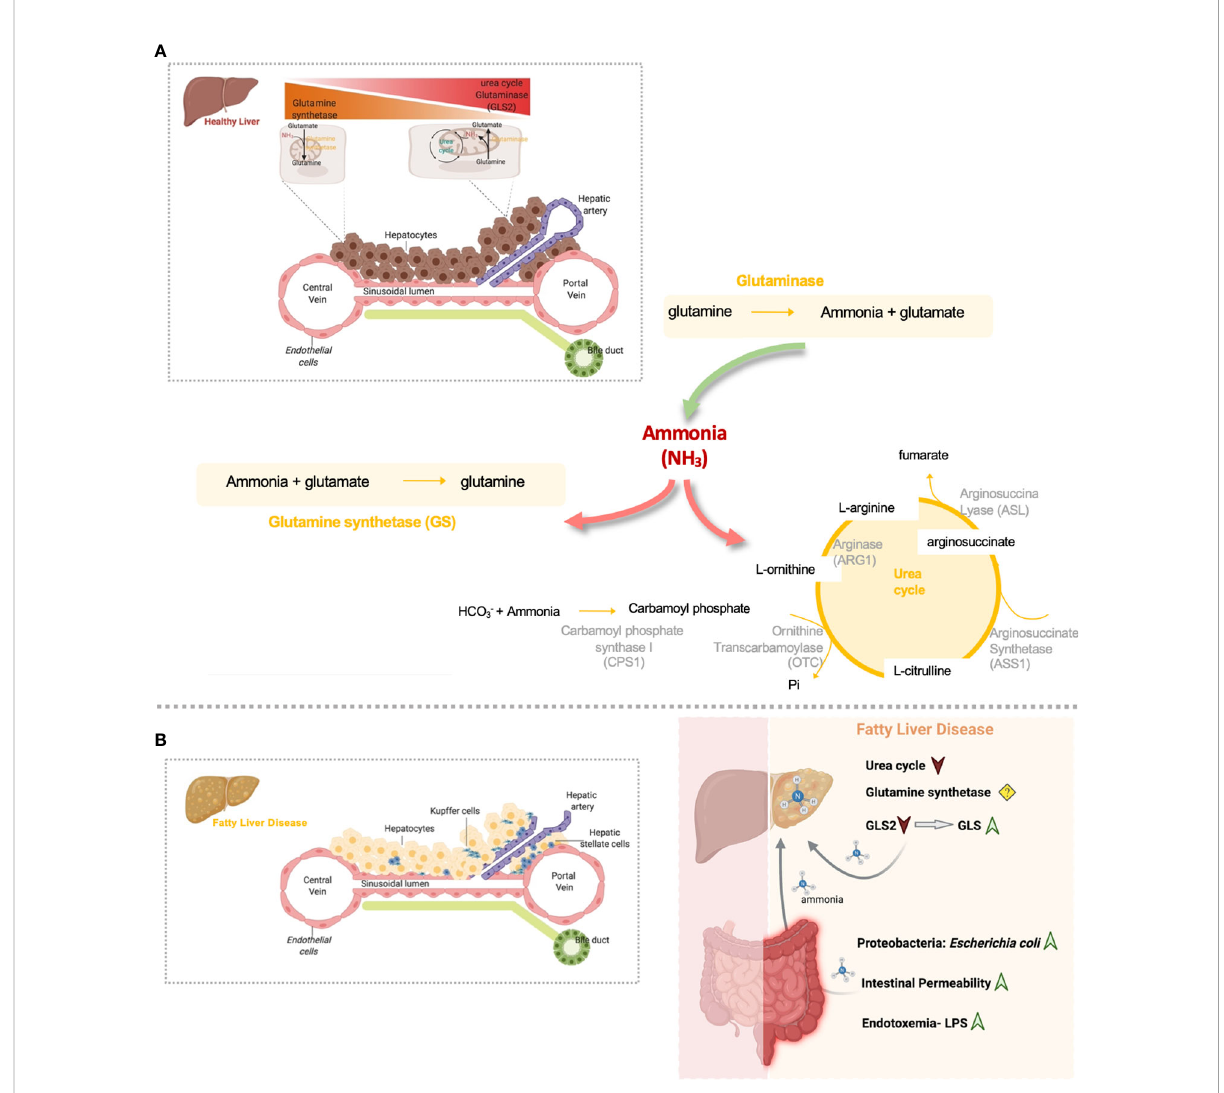
FIGURE 1 Overview of hepatic nitrogen metabolism homeostasis and disrupted gut-liver nitrogen metabolism in Fatty Liver Disease. (A) Both ammonia and glutamine hepatic metabolism are highly zonated processes. Hepatic ammonia enters in the liver from the gut where it can be eliminated by the urea cycle activity. In alternative, periportal hepatic glutaminase can convert glutamine to ammonia. Glutaminase and gut-derived ammonia that is not excreted in the periportal urea cycle, escapes to the pericentral region where is further eliminated by means of the glutamine synthetase (GS) enzyme. This enzyme converts ammonia back to glutamine and closing the glutamine cycle in order to maintain glutamine homeostasis. (B) Nitrogen metabolism homeostasis is disrupted in Fatty Liver Disease. Overall, in fl amed gut in Fatty Liver Disease is characterized by the accumulation of proteobacteria Escherichia coli, very active in the production of ammonia. Gut-derived ammonia ef fl ux through the portal vein can damage the liver directly or in alternative can exert detrimental effects on gut permeability and might indirectly contribute to NAFLD facilitating toxic molecules drainage into the portal blood. Additionally, it is possible that endotoxin and in fl ammation may contribute to increased uptake of ammonia from the gut into the bloodstream and thereby contribute to the latter ’ s toxic effect on the liver. In addition, Fatty liver Disease is characterized by diminished hepatic urea cycle activity and a switch from the low activity GLS2 to the high activity glutaminase, GLS, that together induce the accumulation of ammonia content in the liver. Ammonia can further drive fi brosis by promoting hepatic stellate cells activation, the main fi brogenic cell type. (Created by